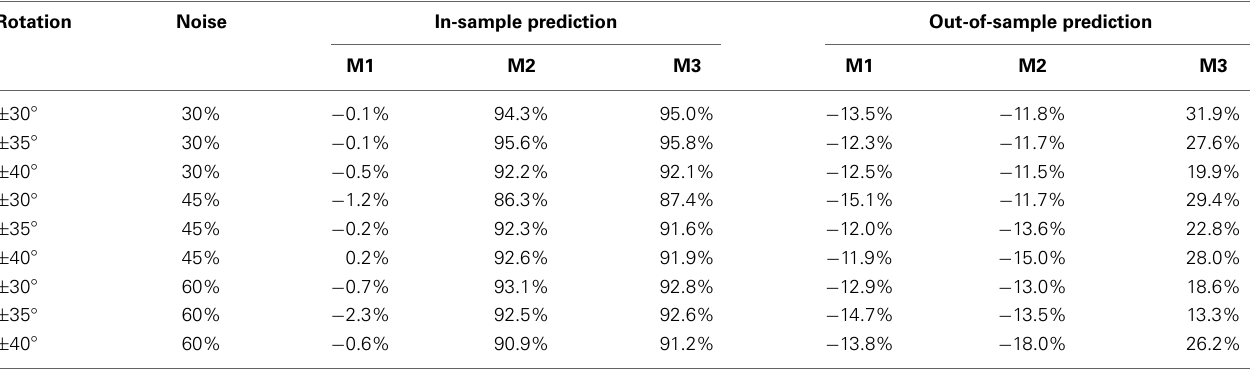
Table 1 | Percentage of between-subject variance in correct-RT medians explained by in-sample and out-of-sample prediction ( R 2 experimental